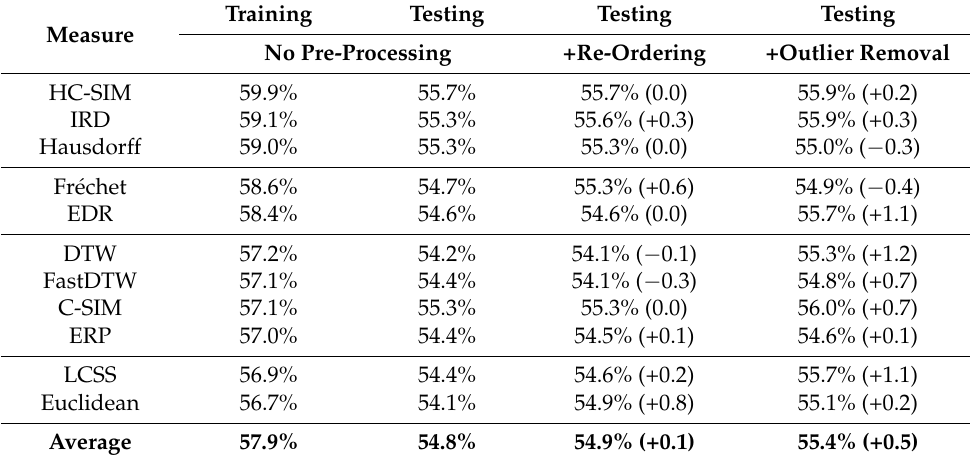
Table 3. Evaluation of medoid accuracy with various similarity measures on trajectories data with and without pre-processing. Results are given separately for the training and testing data. The corresponding results for the baseline segment averaging [7] are 66.9% (training) and 62.1%